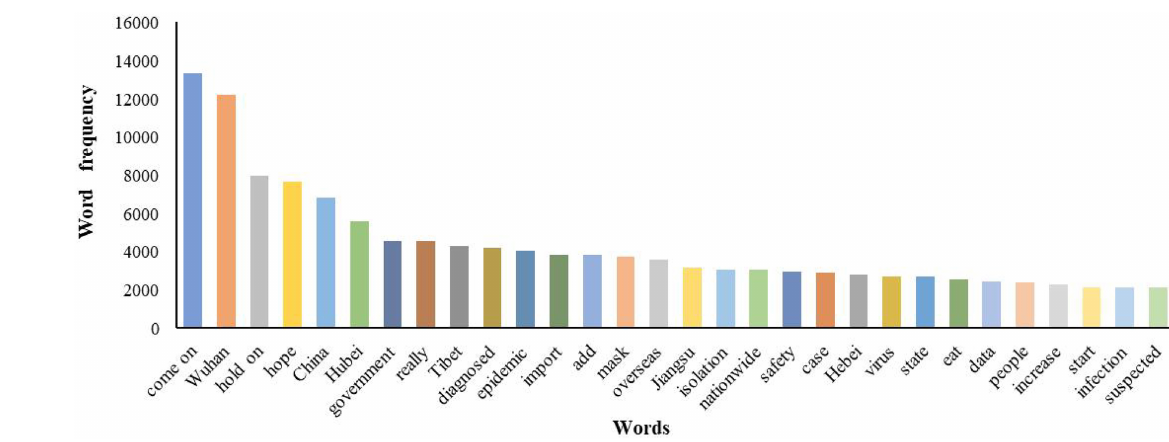
FIGURE 3 | Word frequency statistics.